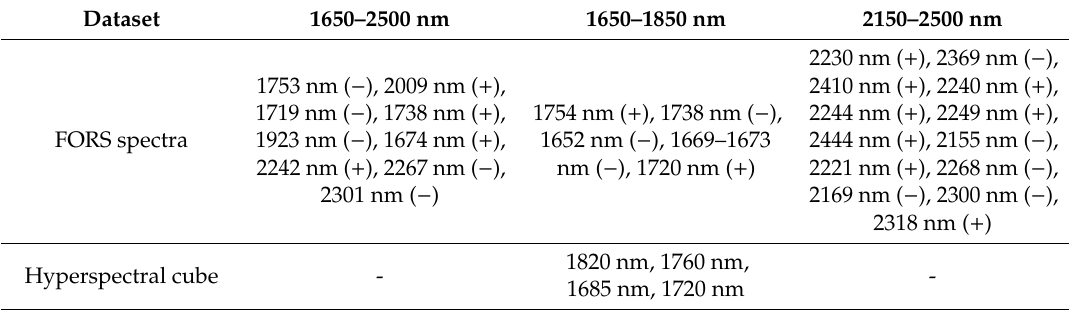
Figure 4. Score plots and related loading plots of principal component analysis (PCA) applied to the first derivative of the FORS spectra acquired from the experimental samples. The different groups of samples are labelled “BASLW(or CLW)_CY(or LW)_LO (or PO)”, where BASLW (or CLW) stands for barium sulphate and lead white ground (or, in the case of CLW, chalk and lead white ground); CY (or LW) identifies the pigment used in each paint (chrome yellow or lead white); LO (or PO) identifies the binding medium (linseed oil or poppy oil) used in each paint. The samples from the area of the canvas where no ground layers were present are labelled as CY (or LW)_LO (or PO). Table 2. Bands that have more impact on the principal components illustrated in Figures 4 and 5, organised by decreasing loading